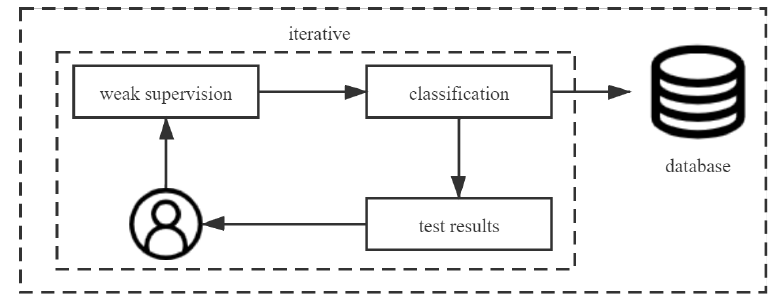
Figure 4. The process of event